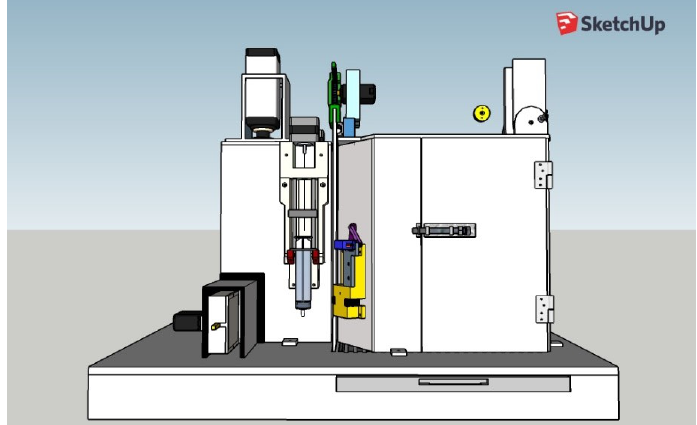
Figure 11. Full automated behavior box: side view.